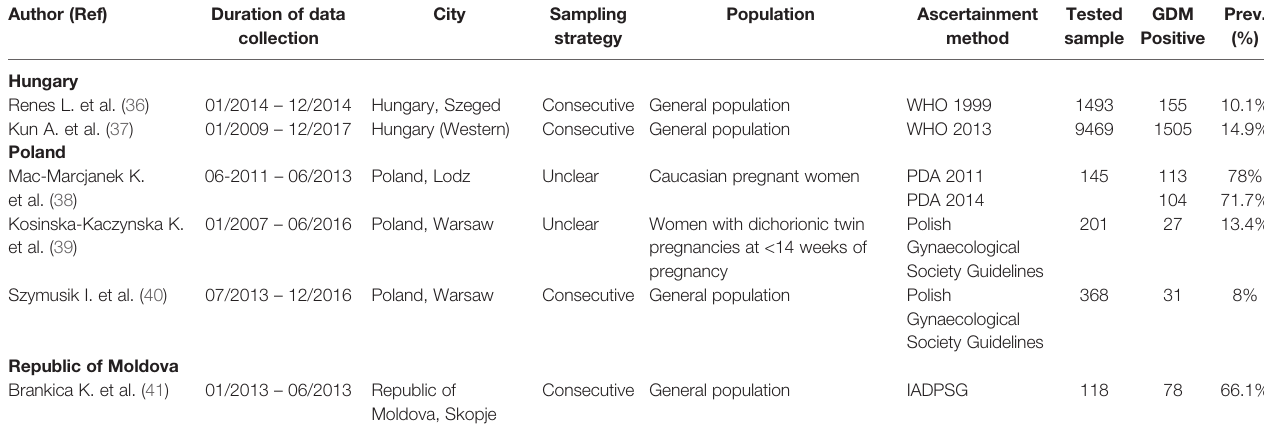
IADPSG, International Association of Diabetes in Pregnancy Studies Group; PDA, Polish Diabetes Association; WHO, World Health Organization.